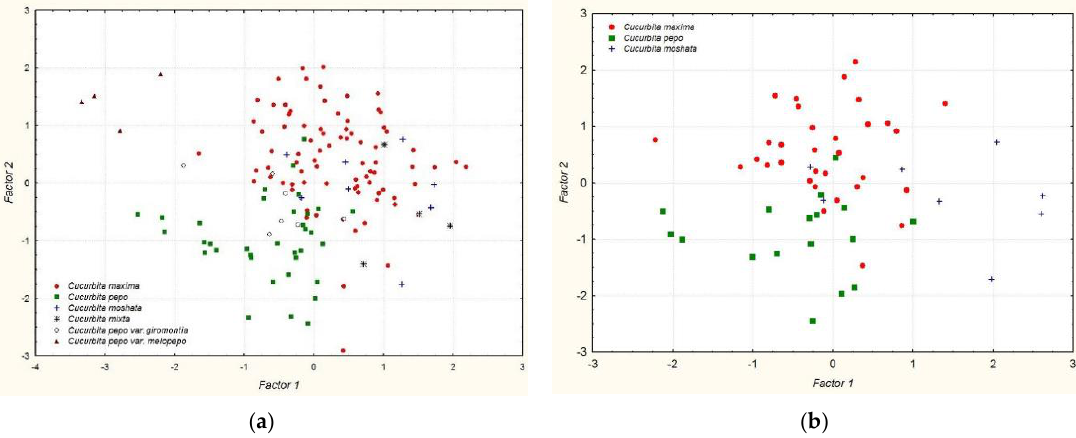
Figure 2. Factor analysis of hull, oil content and FA composition in the studied seeds of C. pepo , C. maxima , C. moshata , C. mixta , C. pepo var. giromontia and C. pepo var. melopepo ( a ) and C. pepo , C. maxima ,